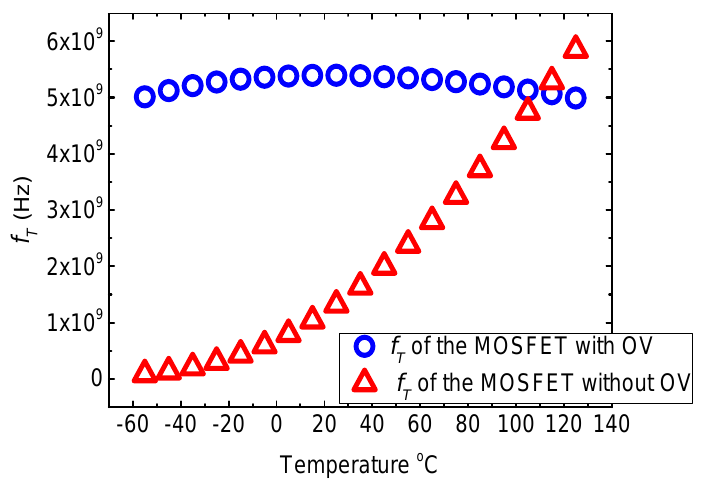
Figure 3. Cutoff frequency versus temperature.